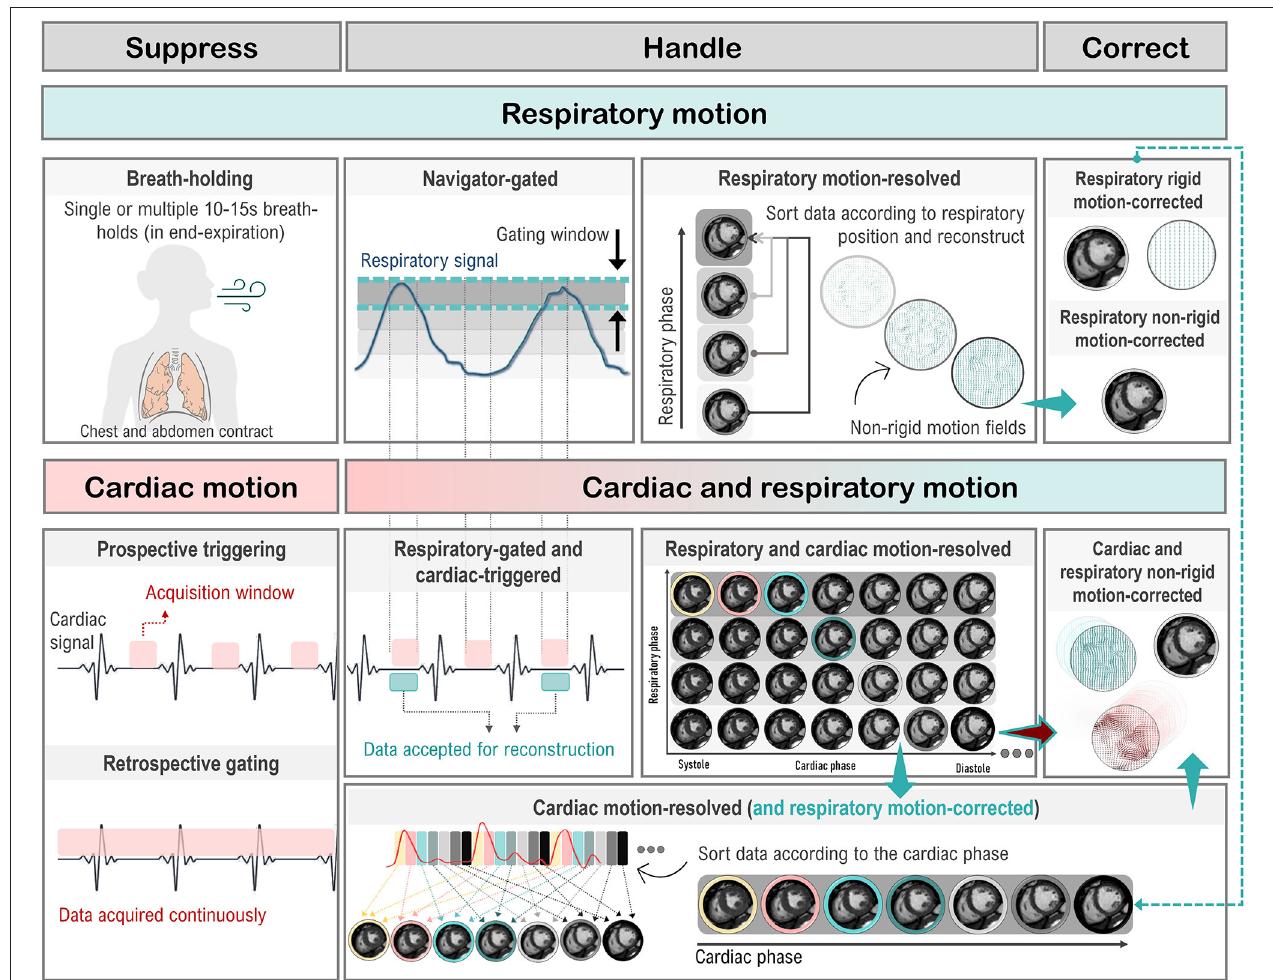
FIGURE 12 | Cardiac and respiratory motion handling. Motion can either be suppressed (left column), handled prospectively or retrospectively (middle columns) or corrected/compensated (right column). Different strategies exist to deal with respiratory-only (top), cardiac-only (bottom left), and respiratory and cardiac (bottom right) motion. Prospective triggering: motion can be triggered to shorten the acquisition window to a specific motion state. Retrospective gating: motion is resolved by gating which can be performed exclusively on either respiratory/cardiac motion or on the joint respiratory and cardiac motion (central gating matrix) to yield respiratory/cardiac motion-resolved data. Data between individual gates/motion states can furthermore be compensated by registering them with a rigid or non-rigid motion field along the respiratory or cardiac motion